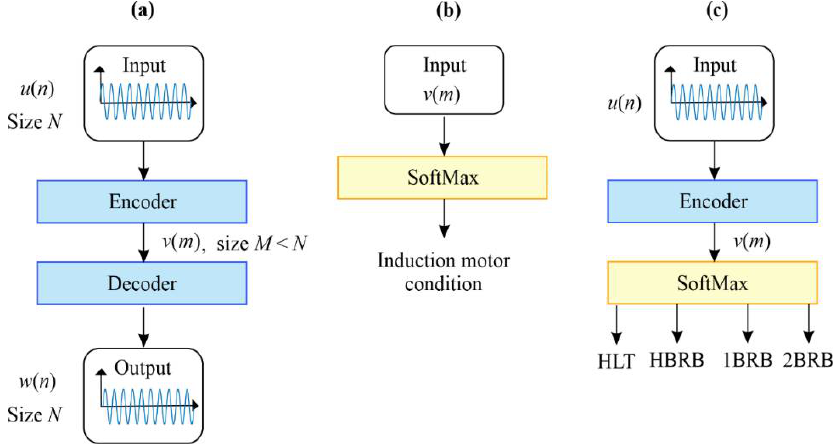
Figure 3. ( a ) Autoencoder structure; ( b ) SoftMax structure; and ( c ) Proposed classification structure.